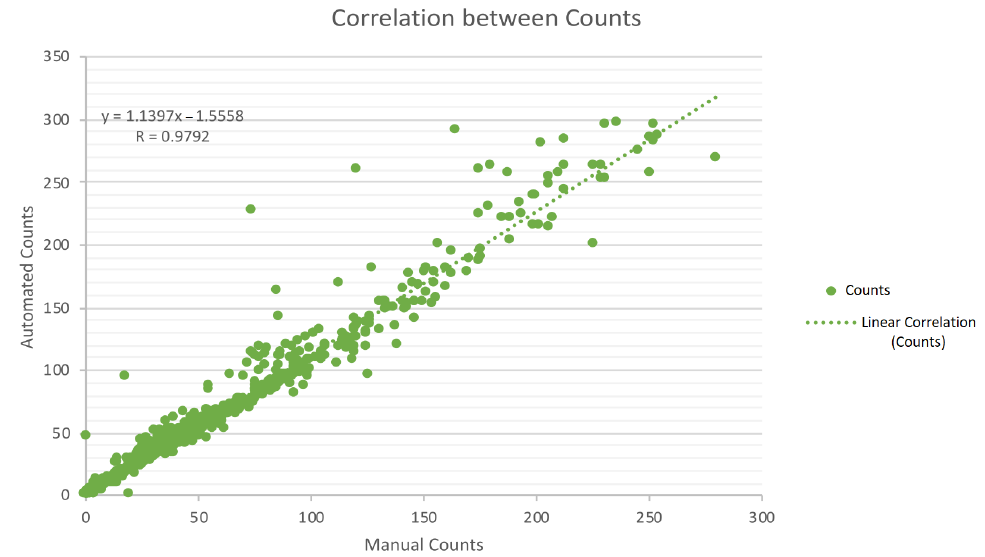
Figure 21. Graphical correlation between automated and manual